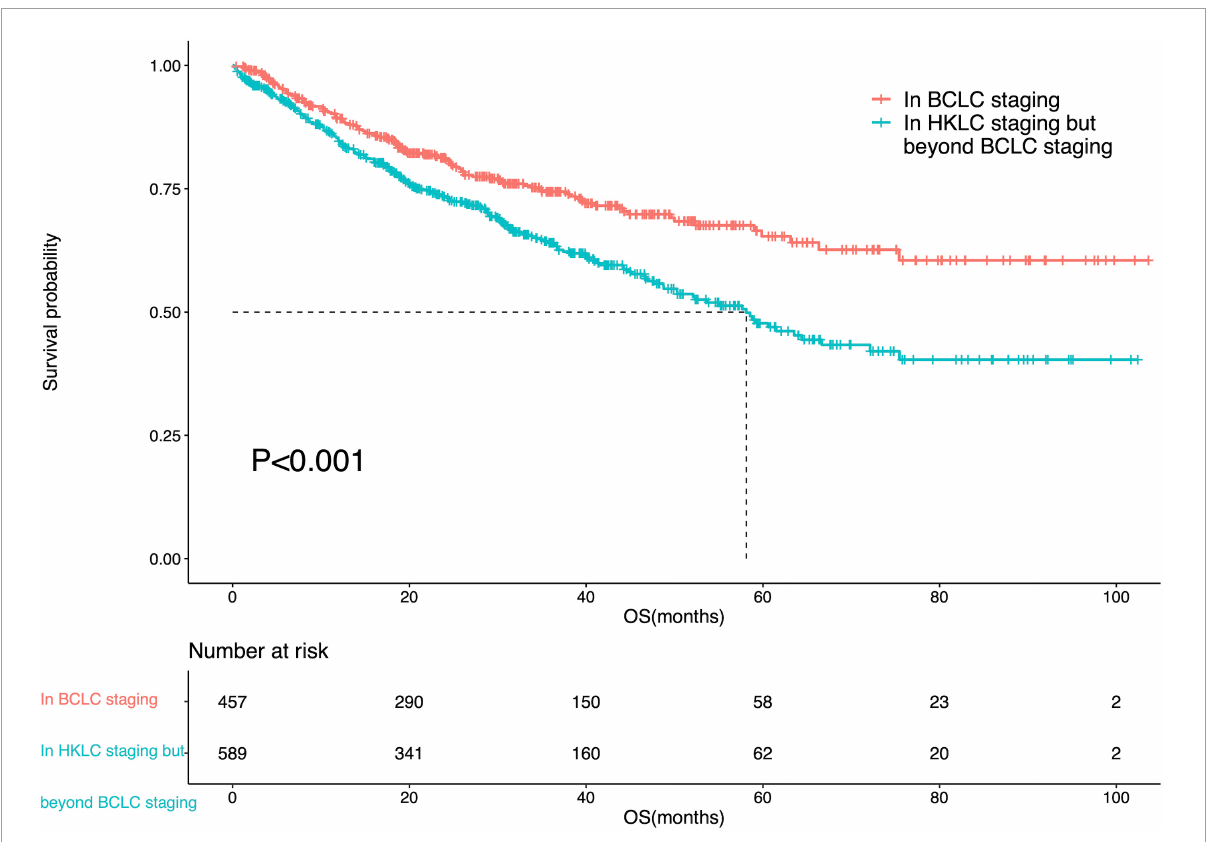
FIGURE5 Survival curve of the IPLRs in the BCLC staging system and those in the HKLC staging system but beyond the BCLC staging